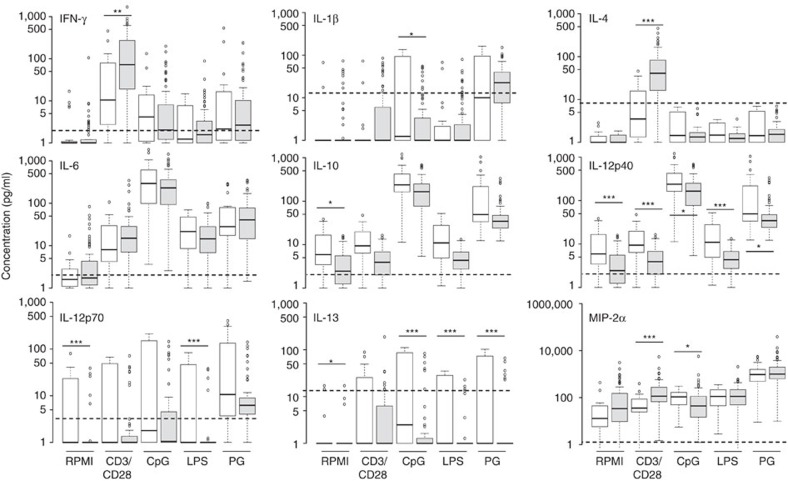
Cytokine production by splenocytes after in vitro stimulation.The concentrations of nine cytokines (IFN-γ, IL-1β, IL-4, IL-6, IL-10, IL-12p40, IL-12p70, IL-13, MIP-2α) produced by splenic lymphocytes stimulated with anti-CD3/anti-CD28, CpG, LPS or PG compared with the RPMI control in wild (shaded) and laboratory (unshaded) mice, shown on a log10 scale. The box centres are medians, and box limits the 25th and 75th percentiles, the whiskers 1.5 times the interquartile range, and outliers are represented by dots. The dotted horizontal lines show the median lower limit of quantification defined from standard curves across all analysed plates for each cytokine. Asterisks denote significant differences as *P<0.05, **P<0.01, ***P<0.001 (Mann–Whitney U test; Supplementary Table 5). Sample sizes are shown in Supplementary Data 1 and Supplementary Table 5.